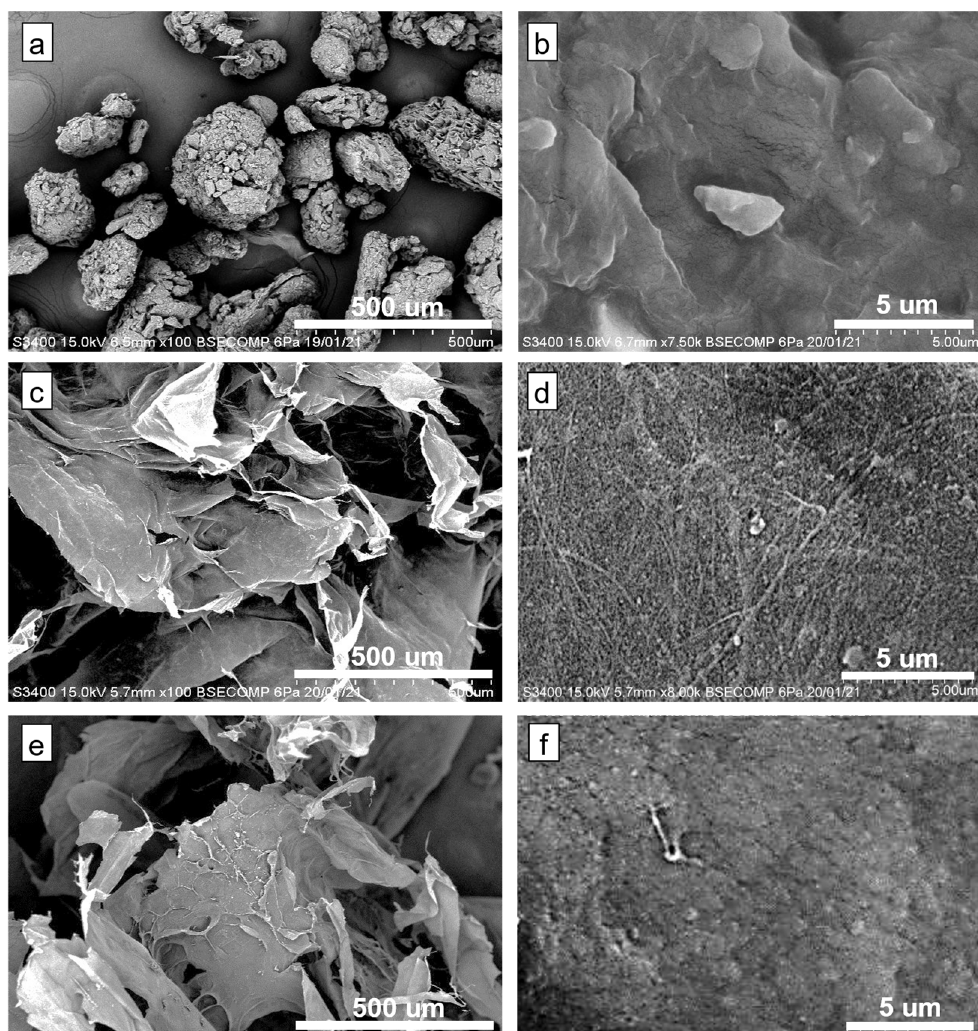
Figure 7. SEM images of ( a , b ) Banana peel powder; ( c , d ) Freeze ‐ dried H 2 O 2 ‐ pre ‐ treated banana peel; and ( e , f ) Freeze ‐ dried H 2 O 2 / H 2 SO 4 ‐ treated banana peel. The concentrations of H 2 O 2 and H 2 SO 4 used were 30% and 6%, respectively.